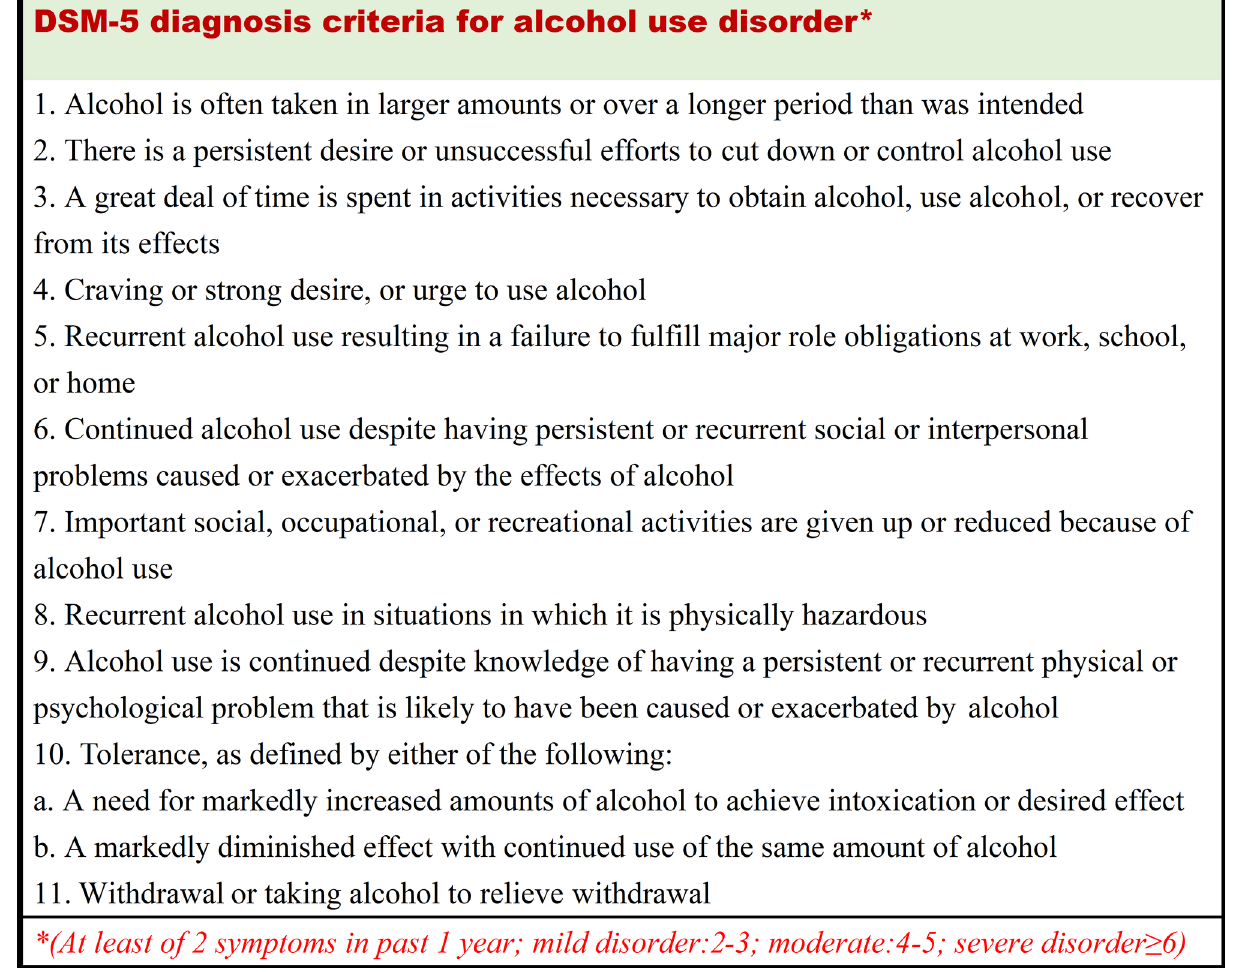
Fig 1. DSM-5 diagnosis criteria for alcohol use